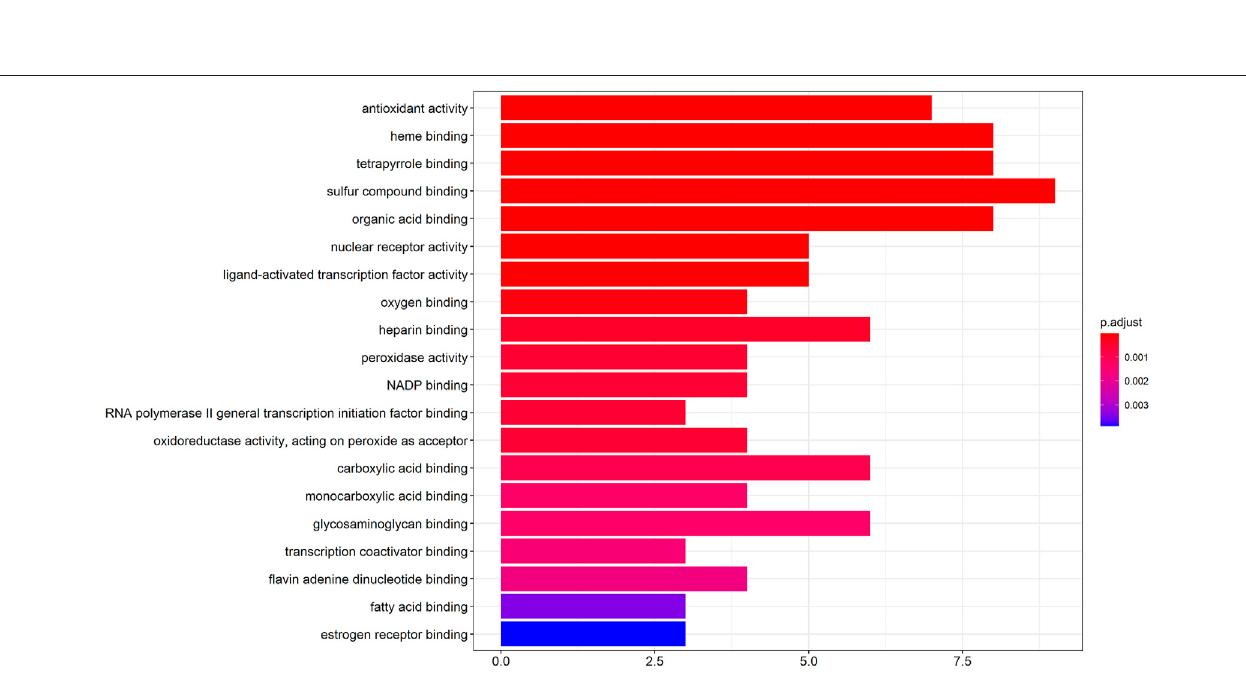
Frontiers in Pharmacology |